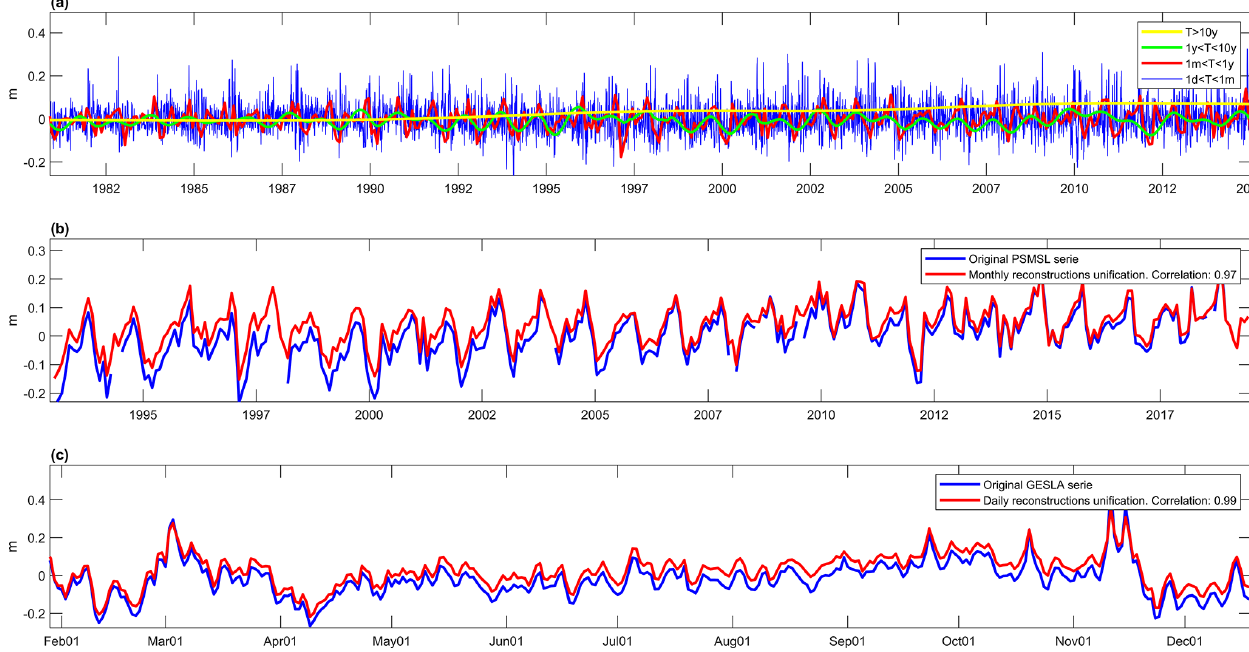
Figure 7. (a) Reconstructions obtained in the four frequency bands for the interpolation point closest to Barcelona tide gauge. (b) Monthly merging of the reconstructed frequency bands and the original monthly series of Barcelona tide gauge. (c) Daily merging of the reconstructed frequency bands and the original daily series of Barcelona tide gauge. Different time intervals are shown for the monthly and daily series in order to better showcase the variability of the merged reconstructions and their differences with the original series.